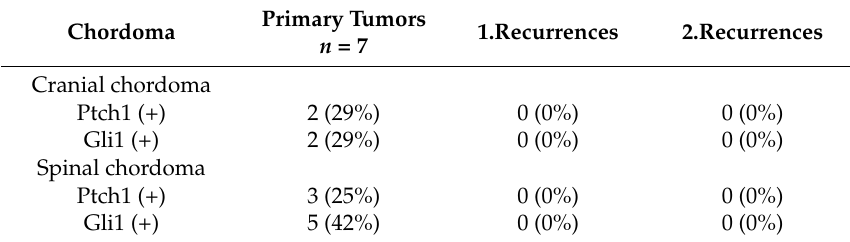
Table 4. In situ hybridization: response of the cranial chordomas in 8 patients corresponding 14 samples that divided into seven primary tumors, 5 first relapses and two-second